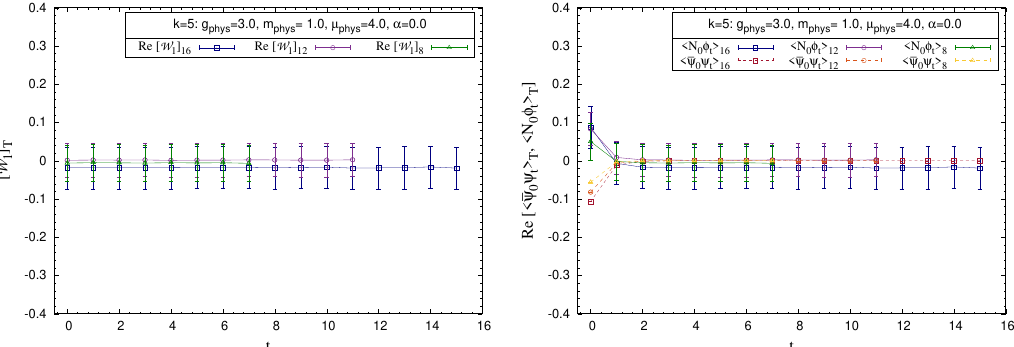
Figure 6 . Real part of the Ward identity (left) and real part of bosonic and fermionic contribu- tions to the Ward identity (right) for the model with odd-degree real polynomial potential. The parameters used are g phys = 3 , m phys = 1 , and µ phys = 4 . 0 on lattices with T = 8 , 12 , and 16 .